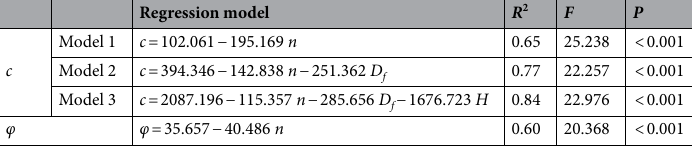
Table 4. Regression analysis of strength and micro-pore structure parameters of